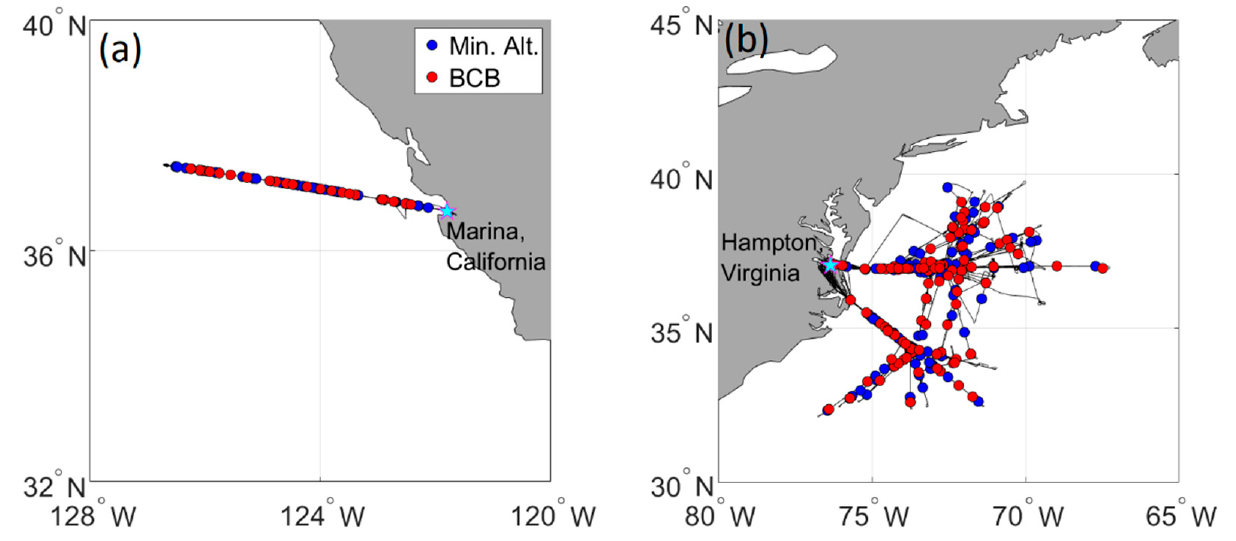
Figure 1. The midpoints of Minimum Altitude (Min. Alt.) and below cloud base (BCB) legs, described more below, overlaid on flight tracks conducted in ( a ) MONARC (May 2019–June 2019)